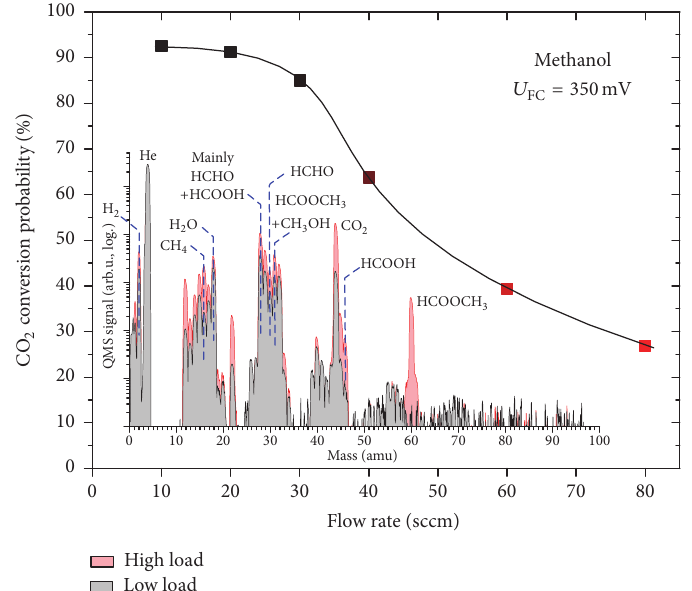
Figure 2: Dependence of the probability of methanol-to-CO 2 conversion on the flow rate of fuel delivered to the fuel cell anode. Methanol concentration was 2 M, cell potential 350 mV. Inset: comparison of typical mass spectra of DMFC anode exhaust acquired at low and high fuel load for the same methanol-fueled